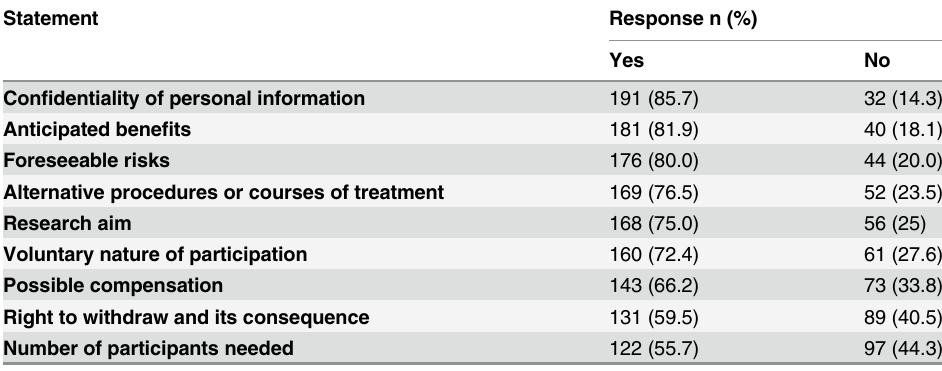
Table 3. Knowledge of respondents towards essential elements of informed consent.